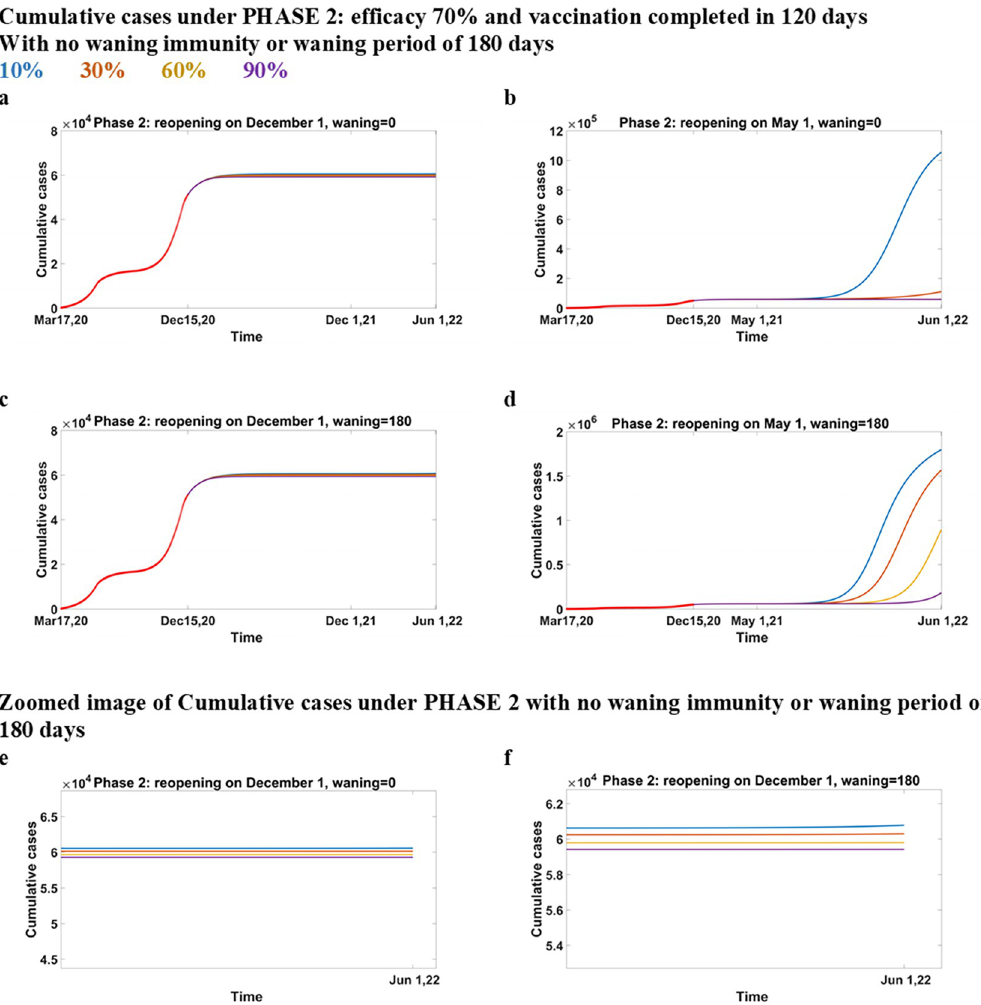
Fig 7. Cumulative cases under Phase 2: Efficacy 70% and vaccination completed in 120 days. Cumulative cases when the vaccine efficacy is 70%, vaccination is completed in 120 days under Phase 2 conditions, reopening in December 2021 (a-c) or May 2021 (b-d) and immunity does not wane (a-b) or wanes over 180 days (c-d). sub-figures (e-f) are zoomed images of sub- figures (a) and (c).